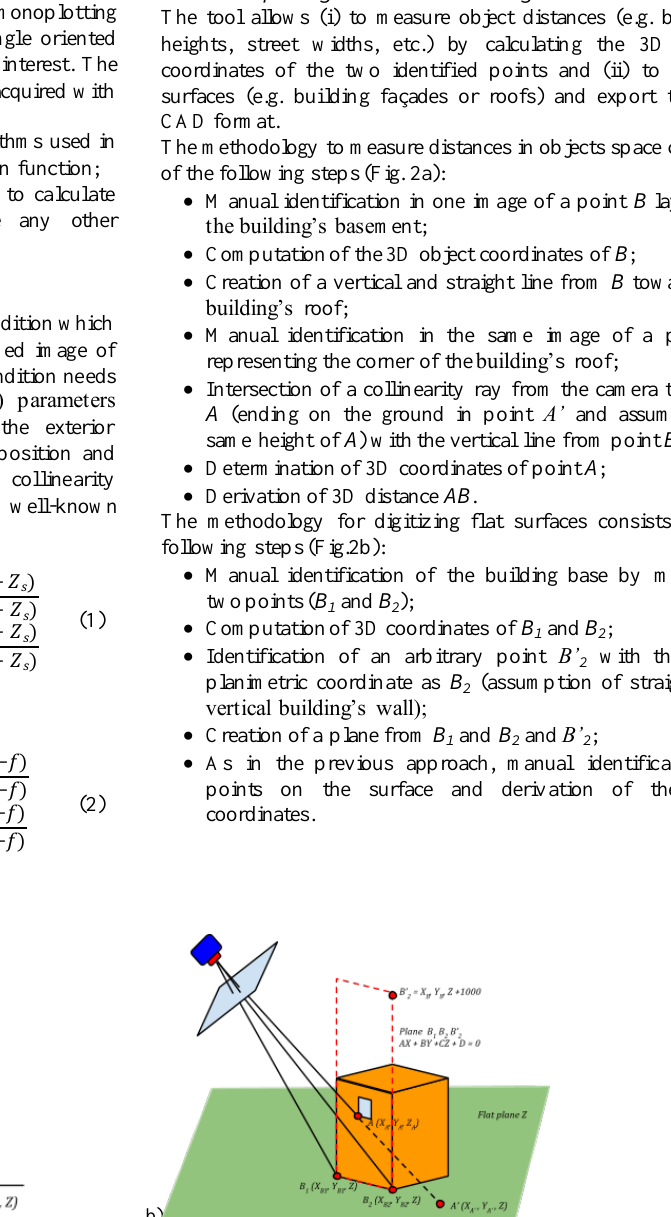
2.2 Tool functionalities The developed tool implements the main